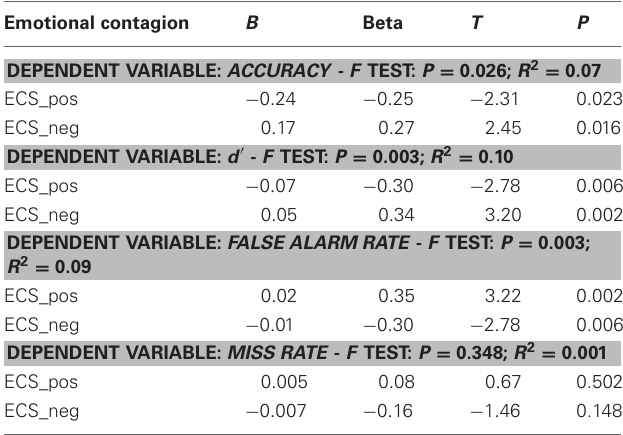
Table 1 | Linear regression analyses of how emotional contagion scales predict smile authenticity recognition (accuracy and d (cid:2) ) and error types (false alarm rate and miss